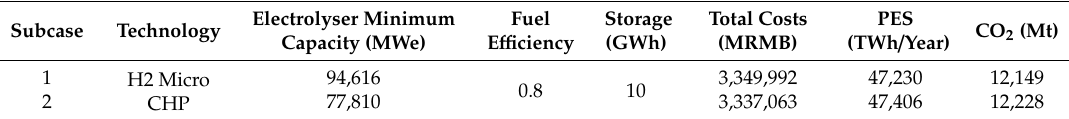
Table 5. Case 1 (H2 Micro CHP) Components Specifications and Summary Performance.